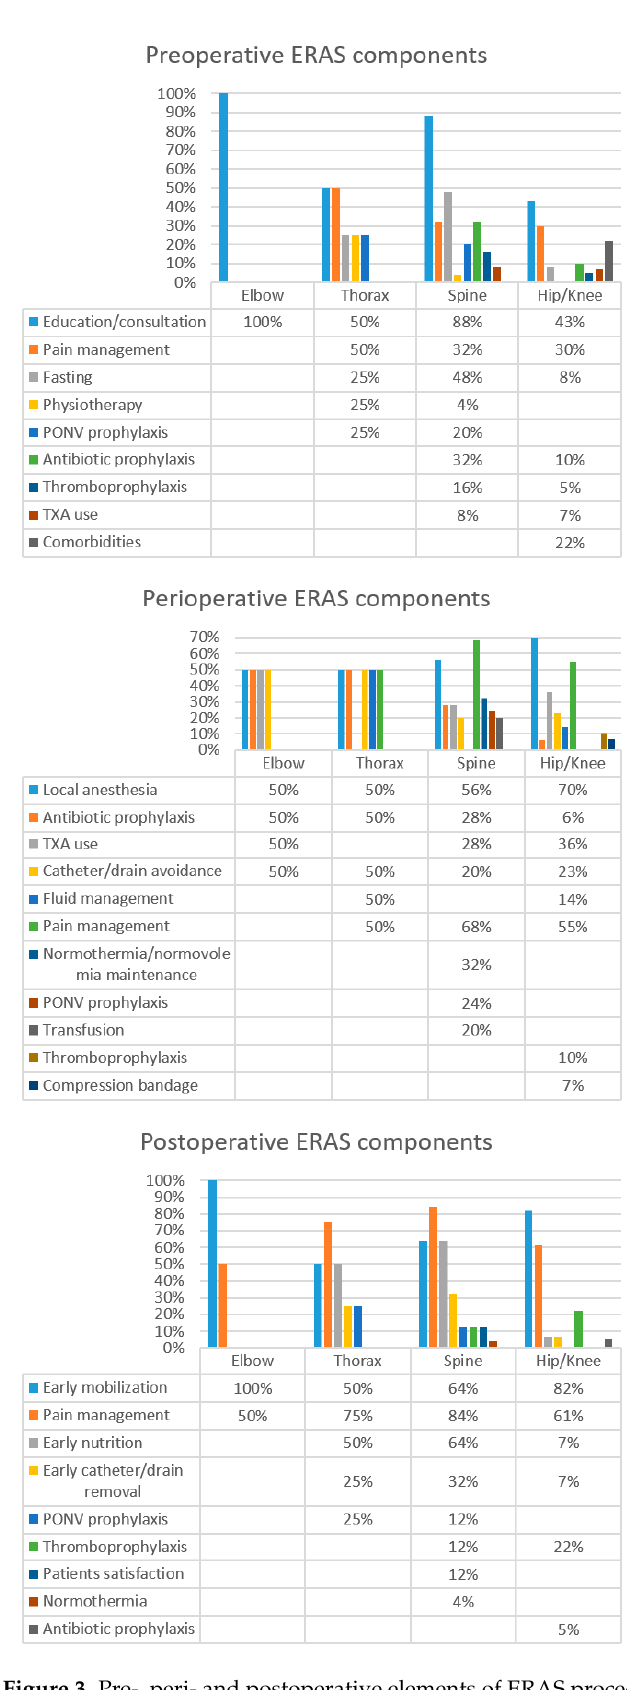
Figure 3. Pre-, peri- and postoperative elements of ERAS procedures.